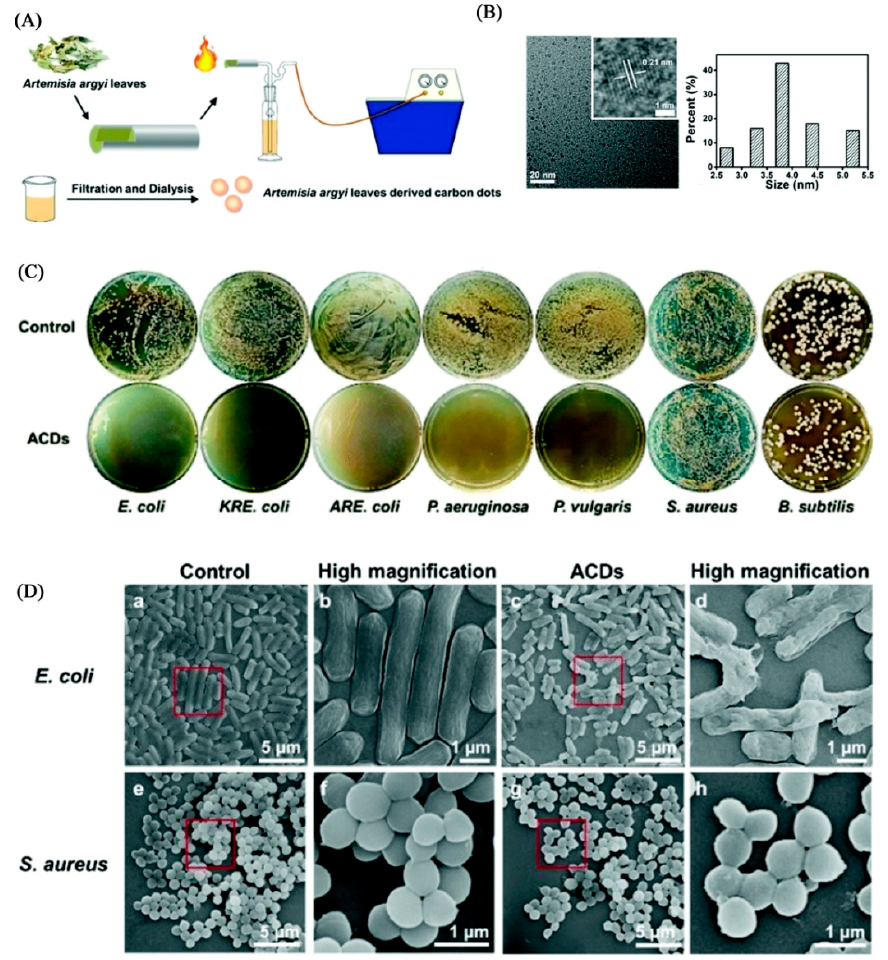
Figure 1. Biomass-derived nitrogen-doped antimicrobial CDs. ( A ) Scheme depicting the synthesis of ACDs. ( B ) Left : Transmission electron microscopy (TEM) image and high-resolution TEM image (inset) of ACDs. Right : corresponding size distribution. ( C ) Effect of 150 μ g mL − 1 ACDs on the growth of E . coli , kanamycin-resistant E. coli ( KRE . coli ), ampicillin-resistant E . coli ( ARE. coli ), P . aeruginosa , P . vulgaris , S . aureus , and B . subtilis. ( D ) Scanning electron microscopy (SEM) images of E. coli incubated without ACDs (a and b) and with ACDs (c and d), and S. aureus incubated without ACDs (e and f) and with ACDs (g and h). ACDs could only disrupt the cell walls of E . coli rather than those of S . aureus . ( A − D ) Reproduced with permission from [39]. Copyright 2020, The Royal Society of Chemistry.